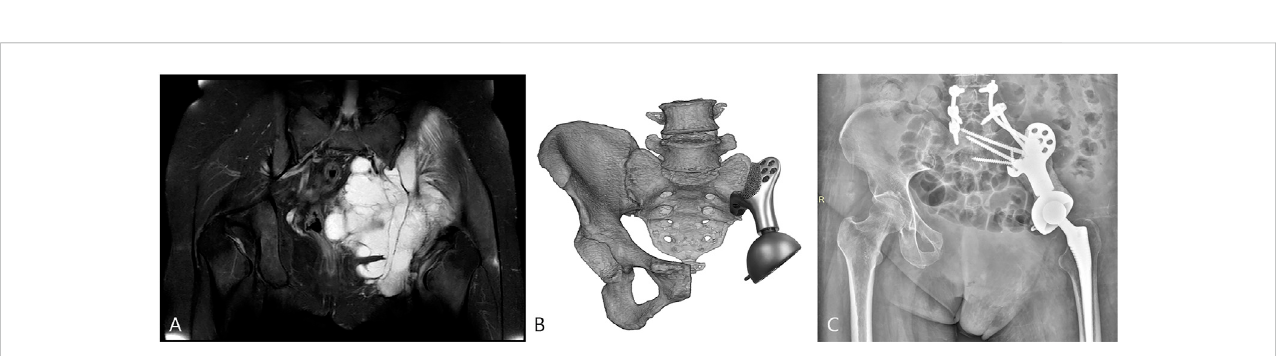
FIGURE 7 Thepatient(case3)withthehighestBMIwasselectedforFEanalysis. (A) Preoperativemagneticresonanceimaging(MRI)showedtheinvolvementofthe sacroiliac joint. (B) The surgery simulation that fi tting the sacral tray onto the ventral sacrum. (C) The postoperative X-ray at the latest